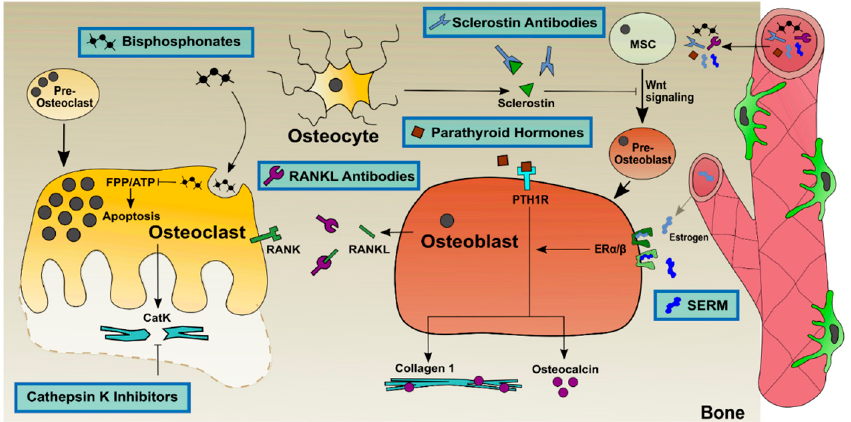
Figure 2. Overview of the different anabolic and catabolic treatments on osteoblasts and osteoclasts for osteoporosis. Bisphosphonates act on adenosine triphosphate and on farnesyl pyrophosphatase and lead osteoclasts into apoptosis. RANKL antibodies bind to osteoblast-produced RANKL and prevent RANKL from binding to RANK on osteoclasts and therefore inhibit activation and differentiation of osteoclasts. Cathepsin K inhibitors inactivate the mature cysteine protease cathepsin K and prevent bone resorption. Sclerostin antibodies bind to sclerostin that is produced by osteocytes, inhibit Wnt signaling and therefore osteoblast differentiation. When sclerostin antibodies are present, osteoblastogenesis is active. SERM are similar to estrogen and can bind to the estrogen receptors α / β , which leads to an activation of